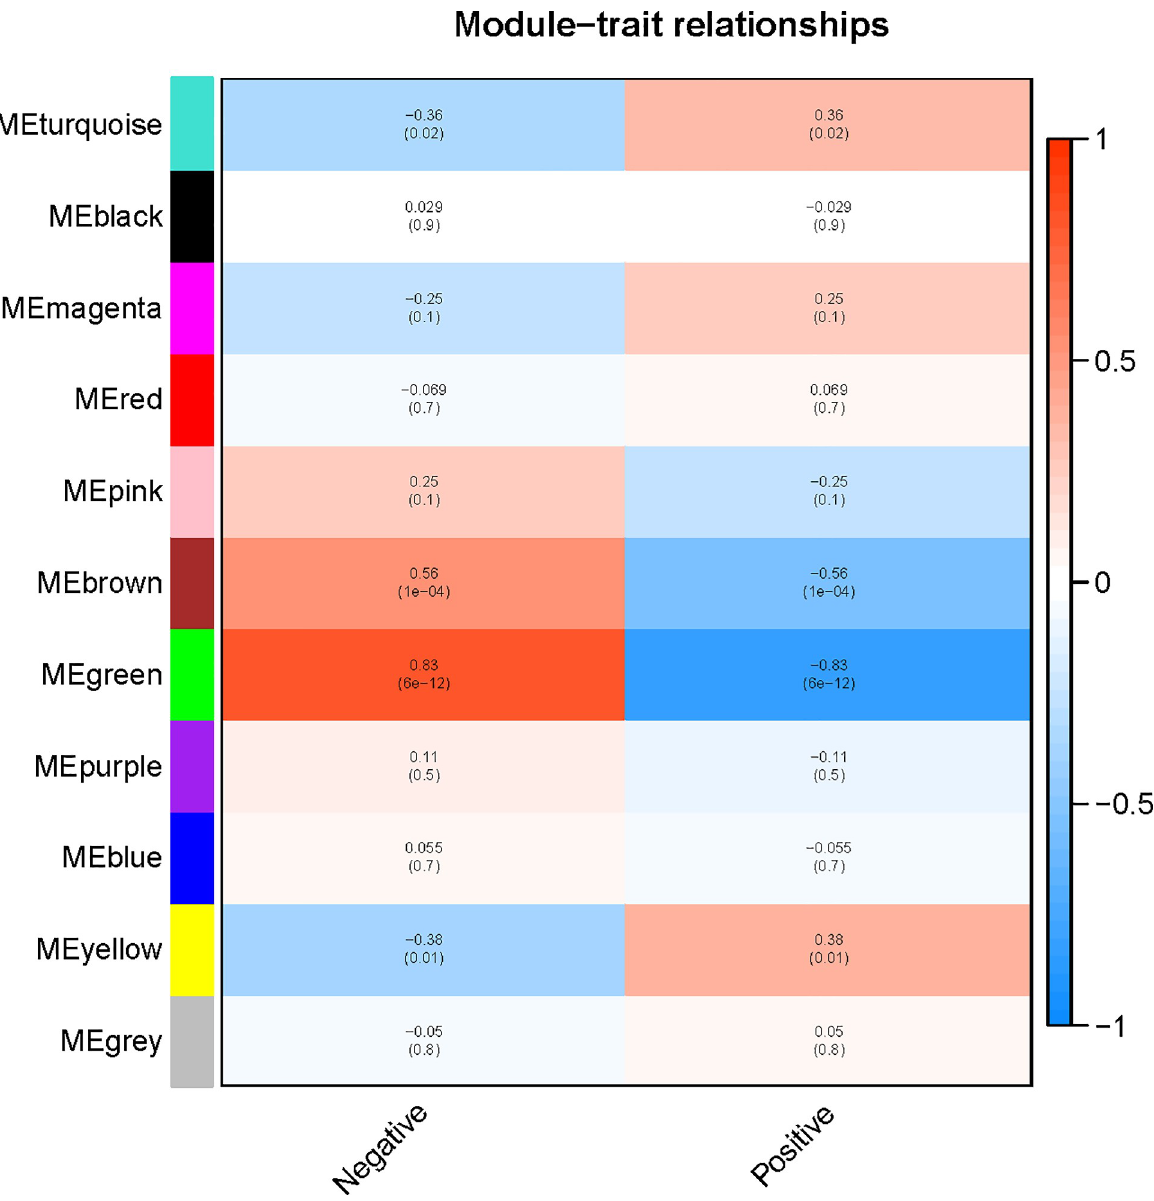
Fig 3. The correlation of each module and positive/negative trait. The green module had a remarkable correlation with the trait. The second significant module was the brown module.